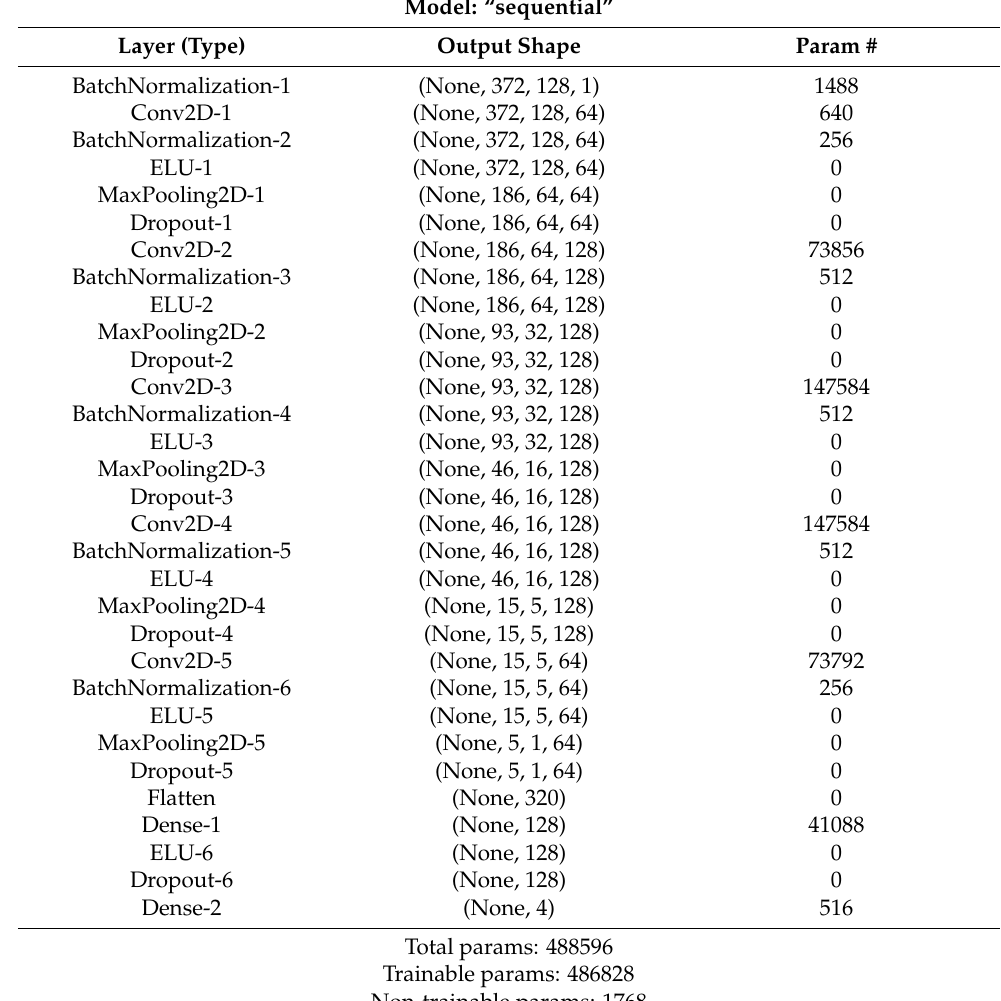
Table 2. Configuration of the CNN model with five convolutional layers for 128 parameters.